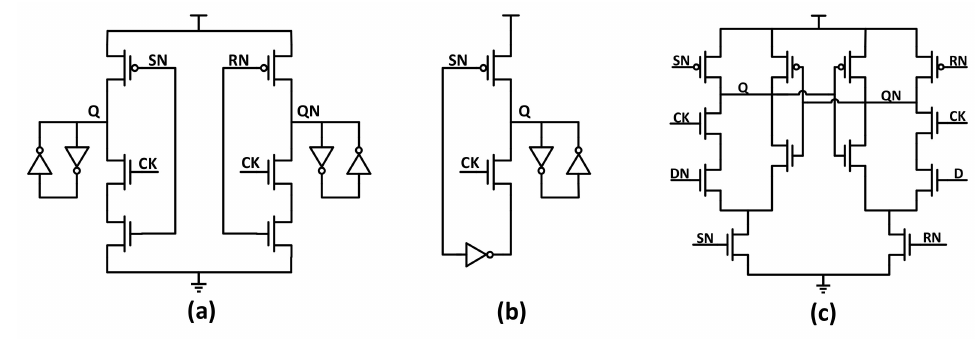
Figure 3. Schematic of the latches in ( a ) Kim’s SAFF; ( b ) Lin’s SAFF; and ( c ) Strollo’s